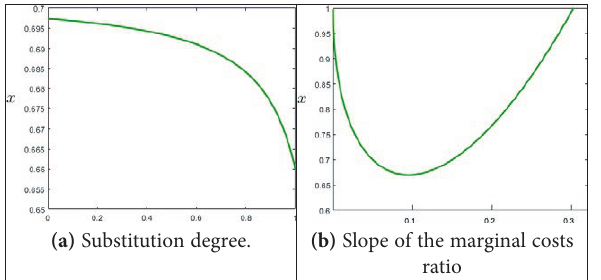
Figure 4. Evolution of the share of PGS firms at increasing values of α , e c / e g